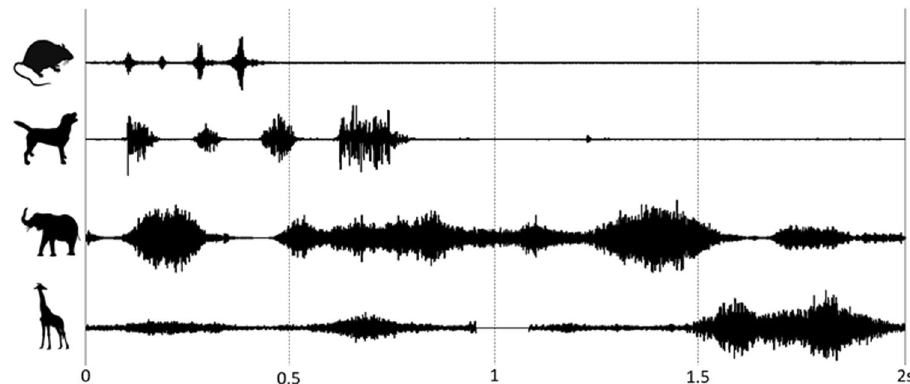
Fig. 1 Audio waveforms of sniff cycles for a rat, dog, elephant, and giraffe respectively. Animal silhouettes are from